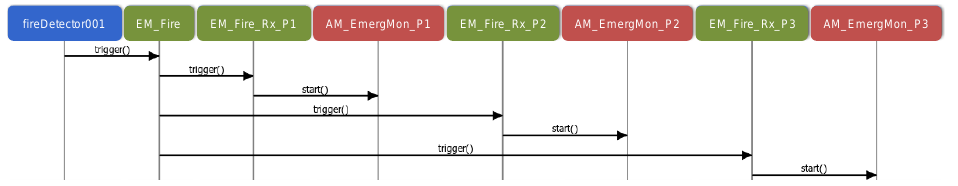
Figure 10. Sequence diagram related to the Fire propagated event.